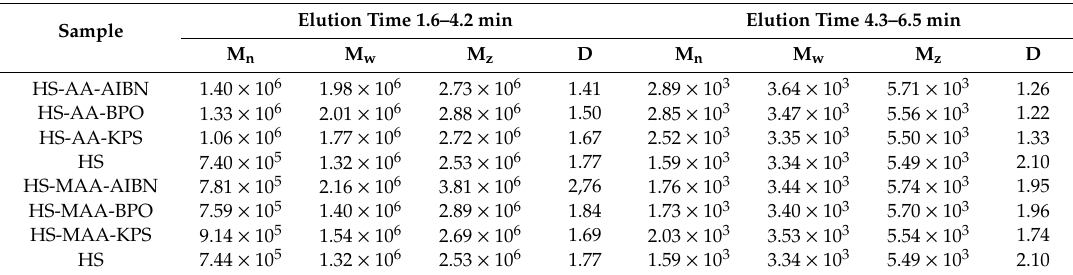
Table 2. Molar weights (g / mol) and degree of polydispersity of HS and copolymer depending on the initiator.